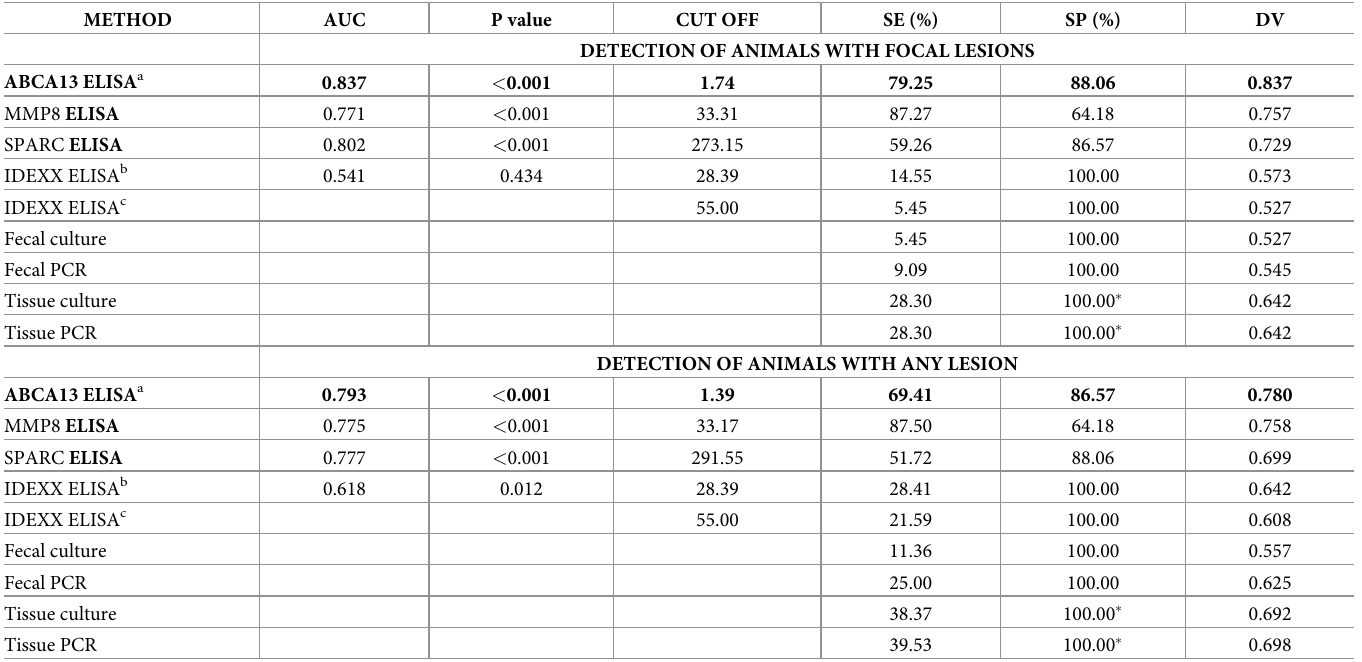
Table 4. Diagnostic performance of conventional diagnostic assays and novel biomarker-based ELISAs for the detection of animals with focal lesions and any type of lesions.